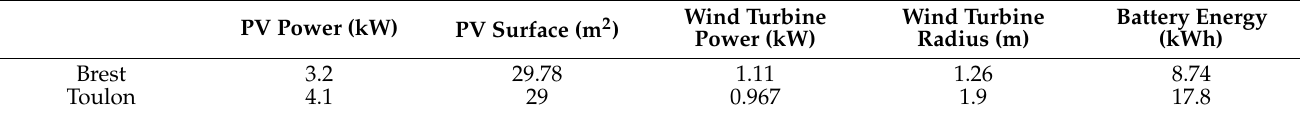
Table 5. Case study 2: PV, battery, and wind turbine sizing results.